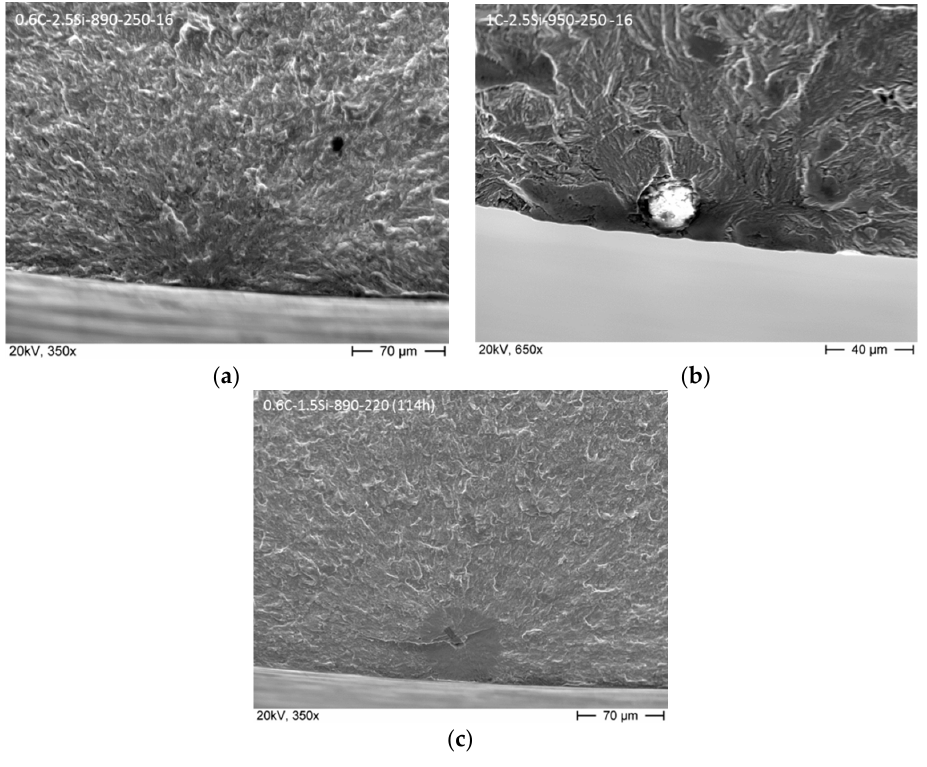
Figure 10. Results of fracture surface analysis. ( a ) Crack initiation at the surface; ( b ) crack initiation at Al 2 O 3 inclusion near the surface; and ( c ) crack initiation at TiN subsurface inclusion.